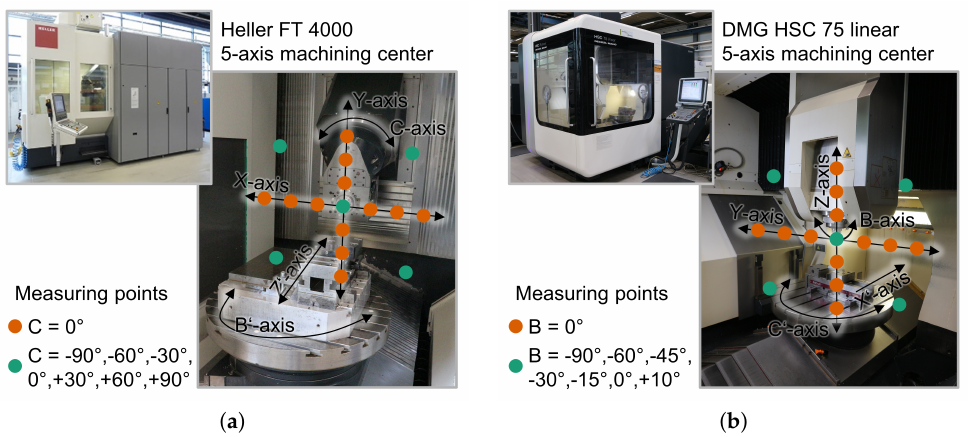
Figure 1. Layout of the axes and measuring points for ( a ) M 1 and ( b ) M 2 .